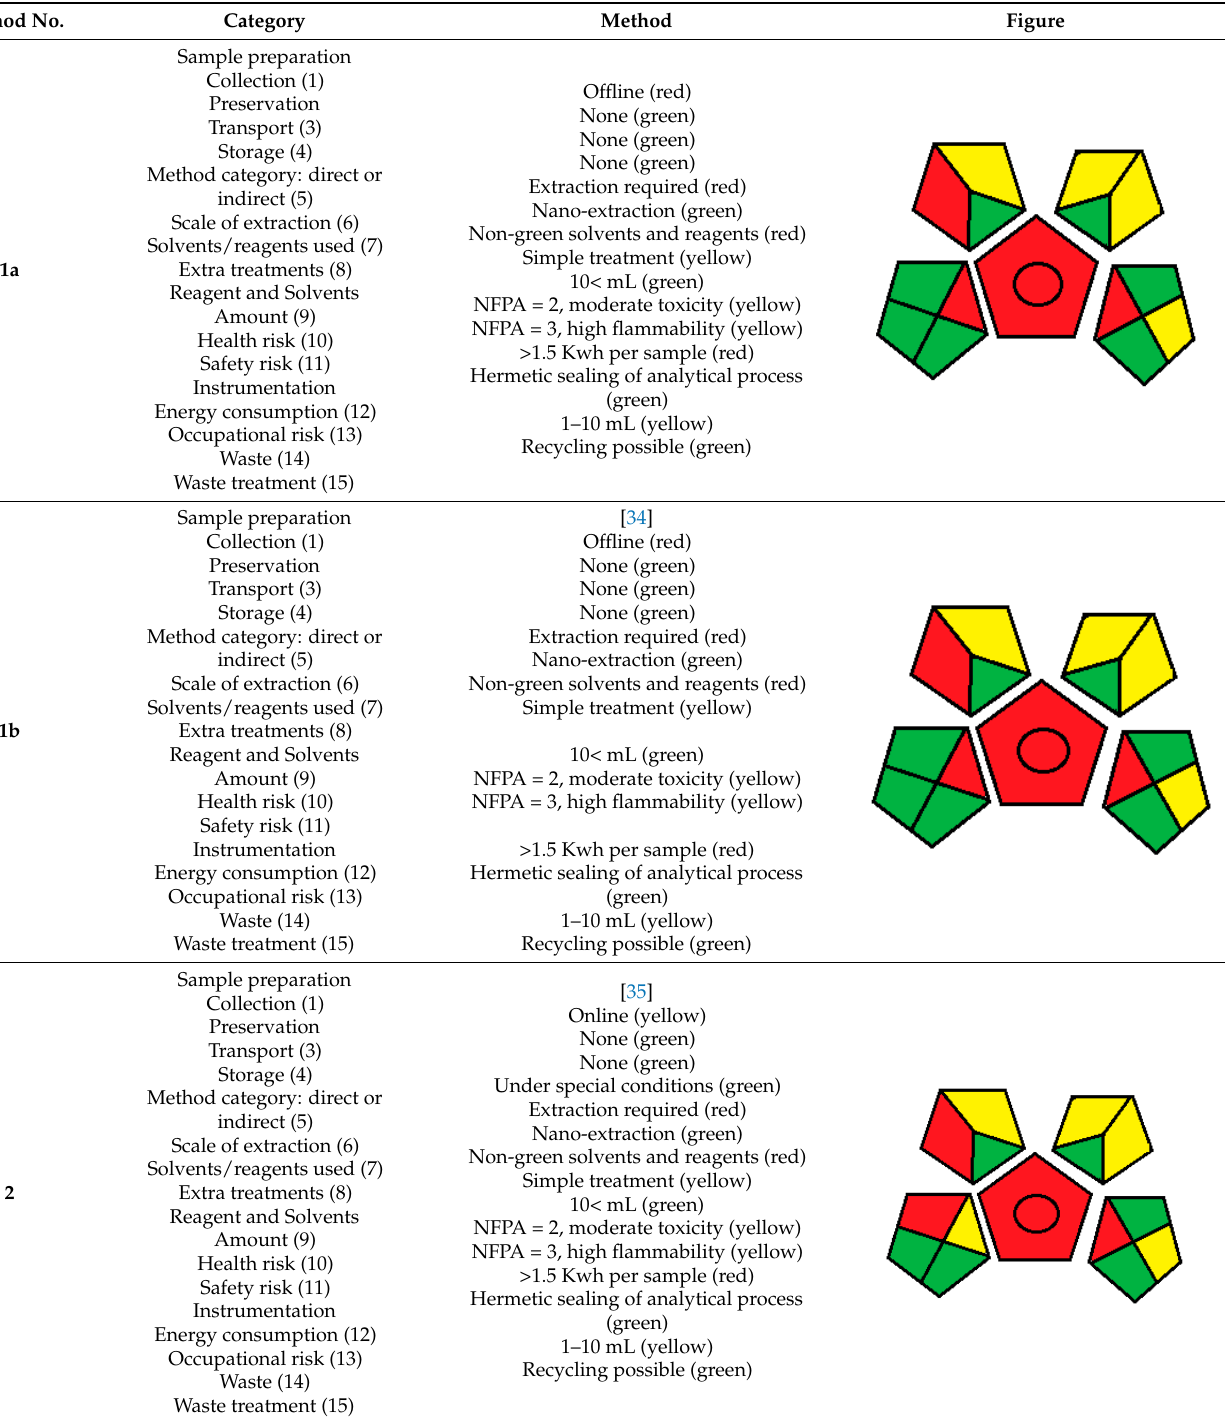
Table 2. Detailed descriptions of Green Analytical Procedure Index (GAPI) parameters for analytical methods of assess- ment of the studied neurotransmitters.